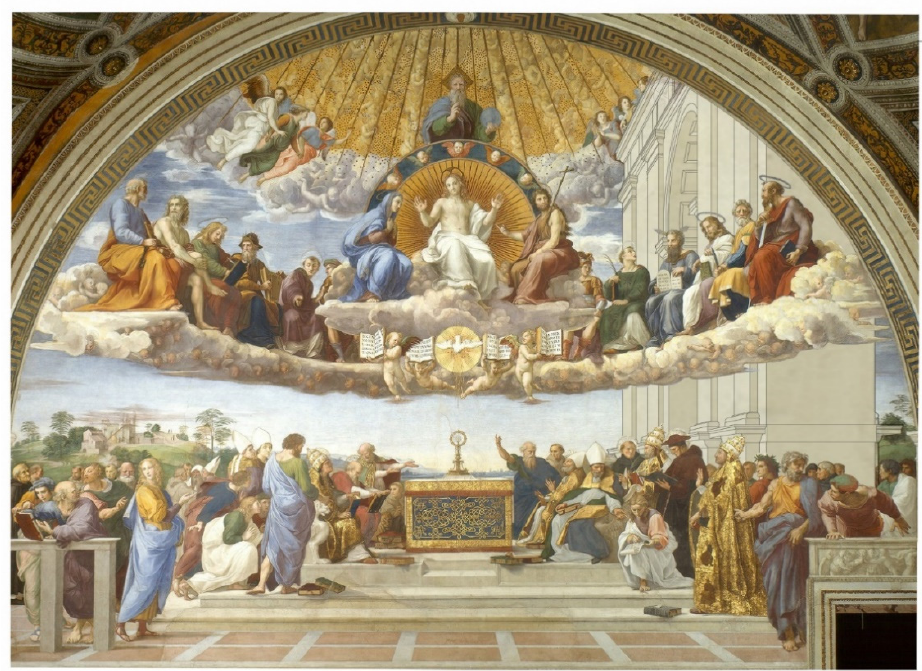
Figure 19. Final version of the digital Photomontage of the Triumphal Arch in Raffaello’s The Disputa considering the stone block as the right pillar.